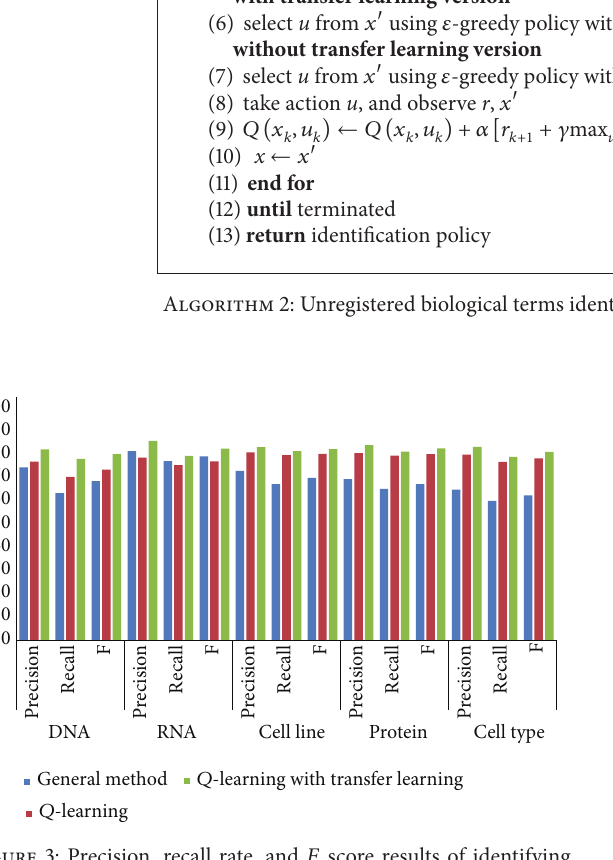
Figure 4: Precision, recall rate, and 𝐹 score results of identifying four kinds of unregistered words: DNA, RNA, cell line, protein, and cell type from